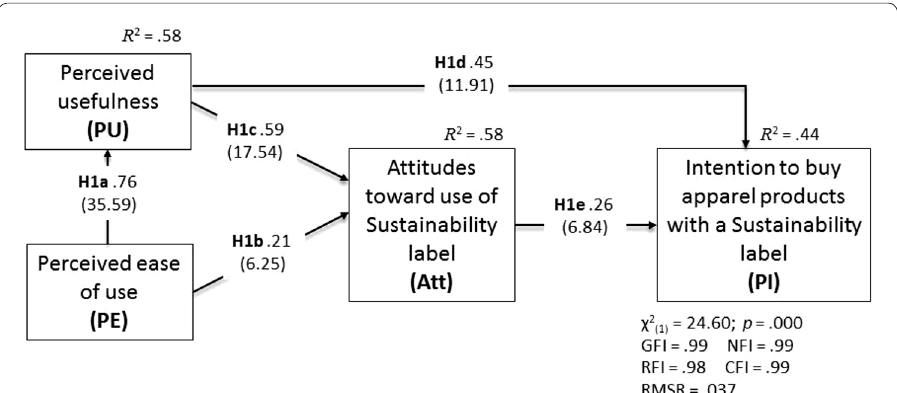
Fig. 2 Result of Path Analysis of Proposed Model (H1a-e). Standardized path estimates are reported with t values in parentheses